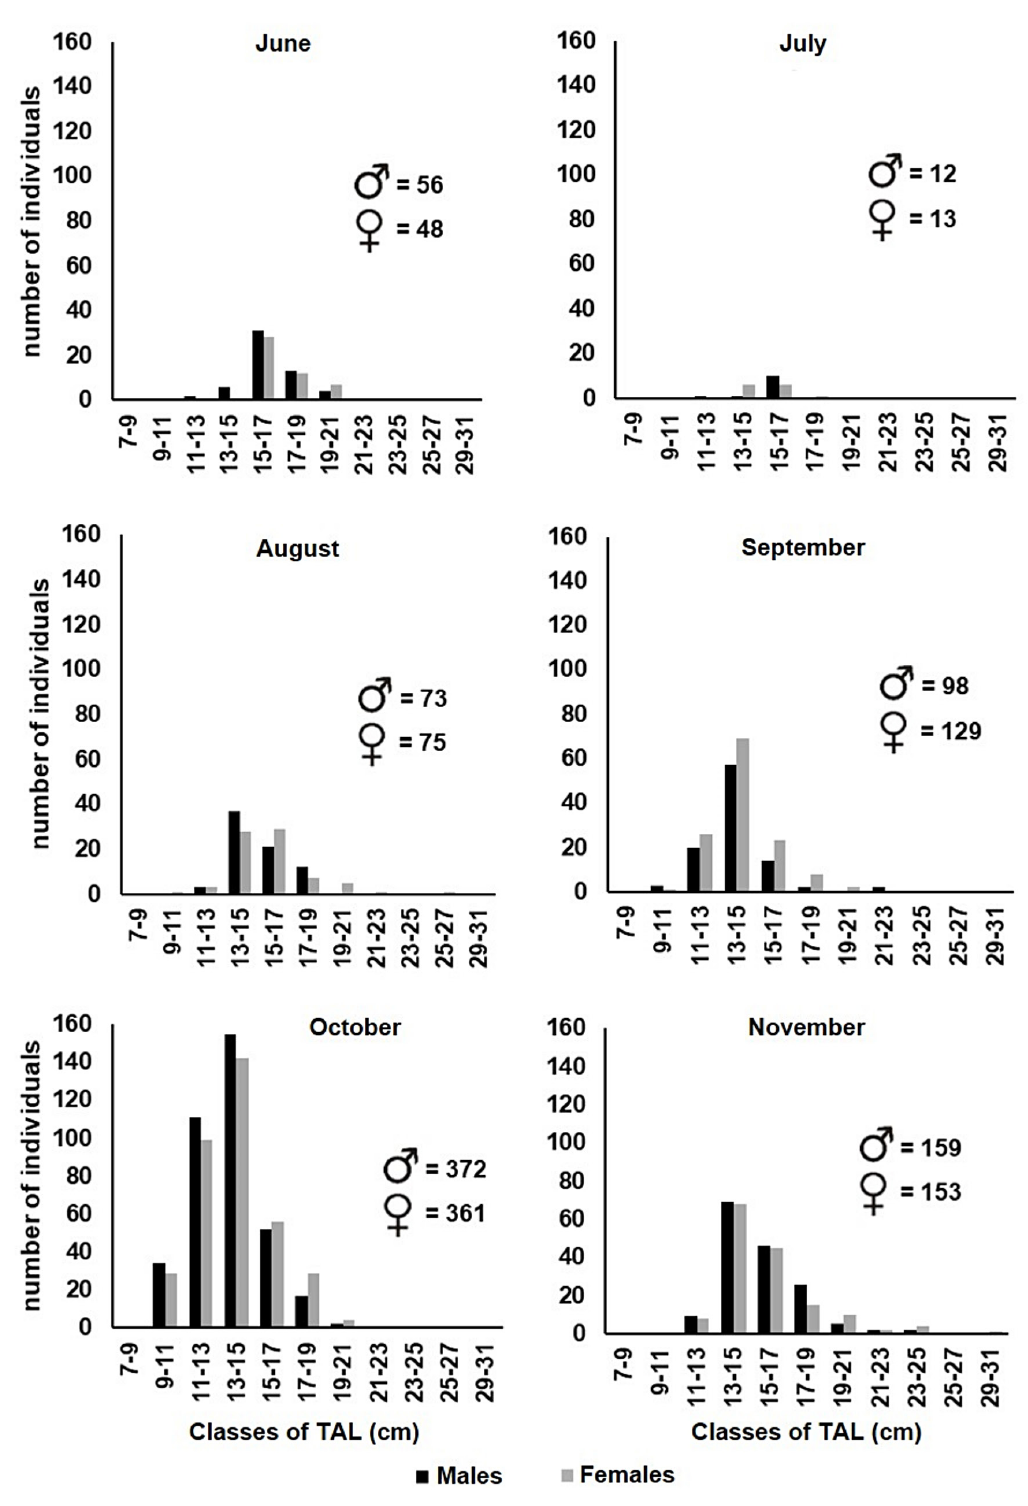
Figure 4. Frequency distribution of tail length classes (TAL), per sampling month and intersexual comparison for the species Panulirus meripurpuratus